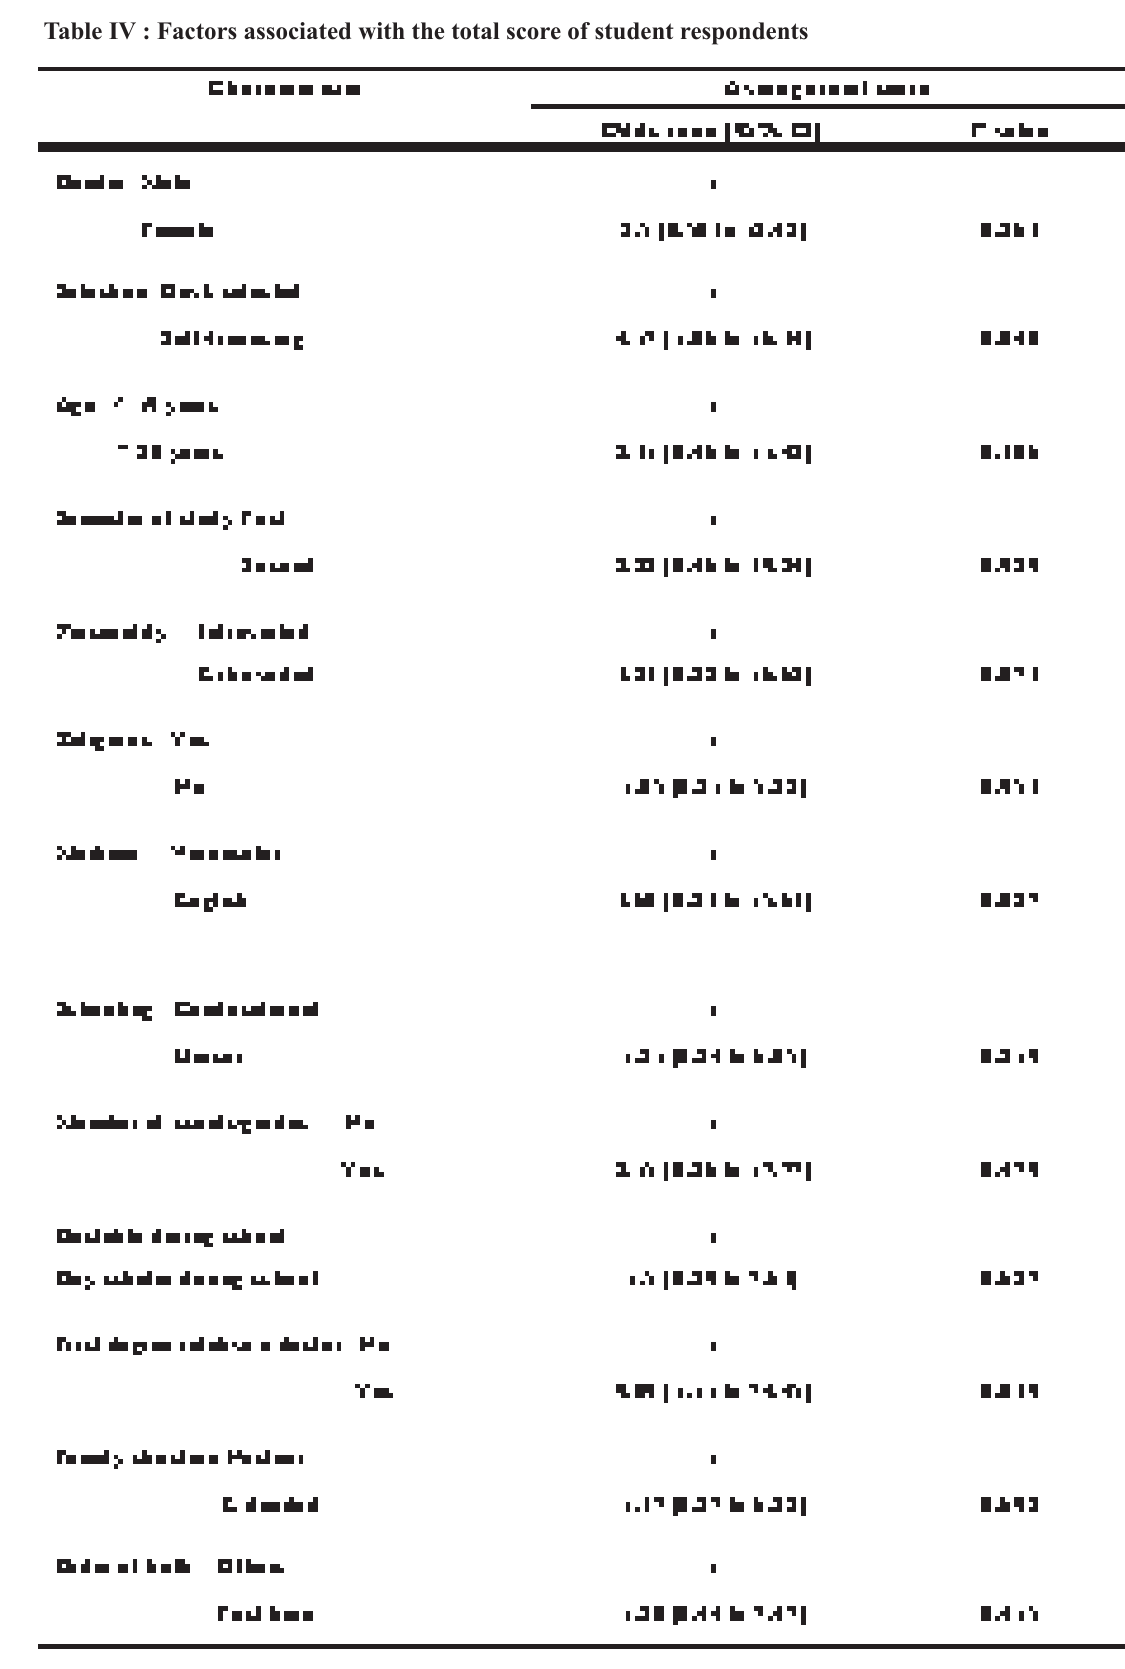
Table IV : Factors associated with the total score of student respondents